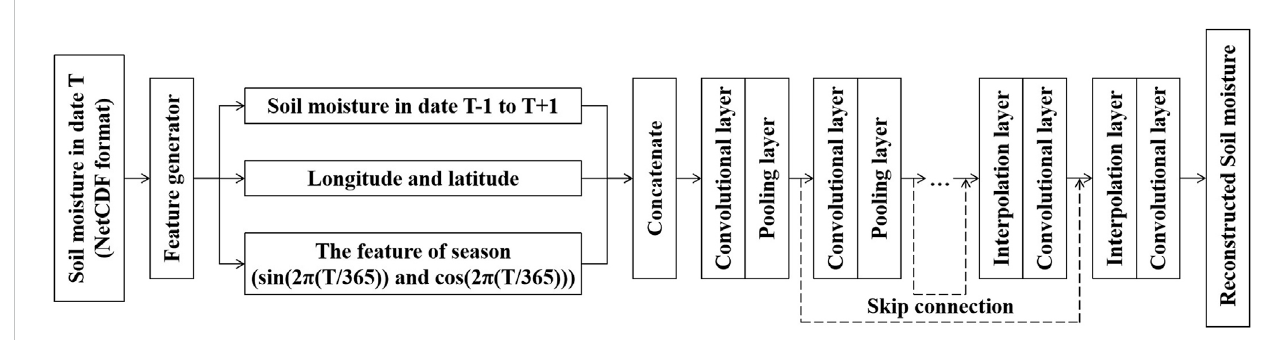
FIGURE 3 Structure of the used CNN model with autoencoding